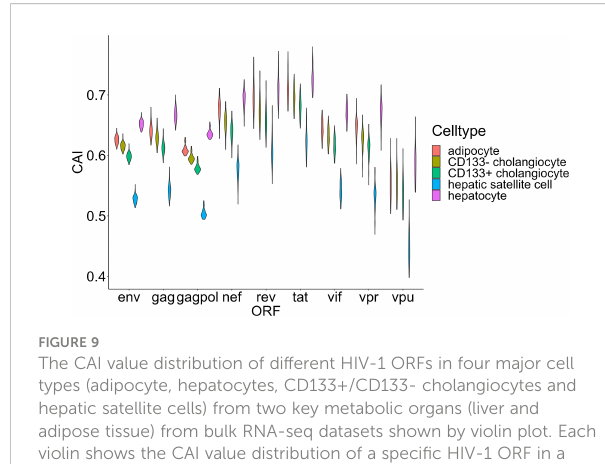
FIGURE 11 The overall CAI value distribution of different SARS-CoV-2 ORFs in all cell types/large groups from the lung scRNA-seq dataset shown by violin plot. Each violin shows the CAI value distribution of a speci fi c SARS-CoV-2 ORF in all cell types/large groups from the dataset (containing the reference genome and 25 genomes belonging to 5 variants of